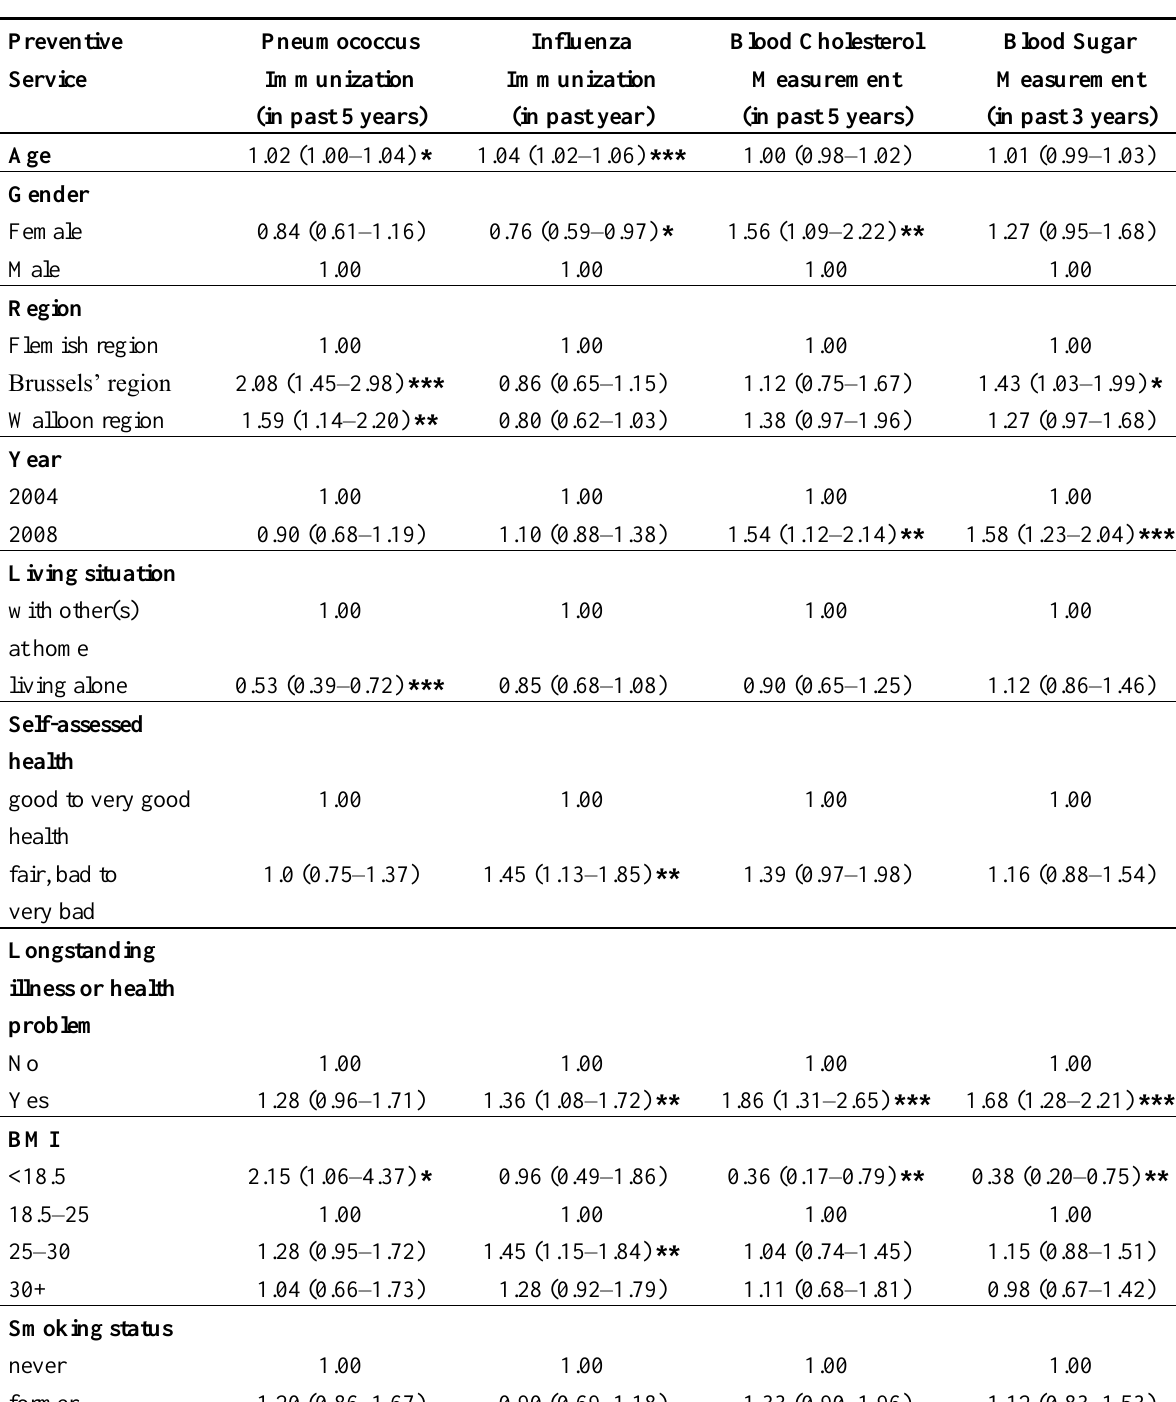
Table 3. Use of preventive services by respondents 65 years and over (n = 1,649) according to socioeconomic status after adjustment for sociodemographic variables, health status and risk